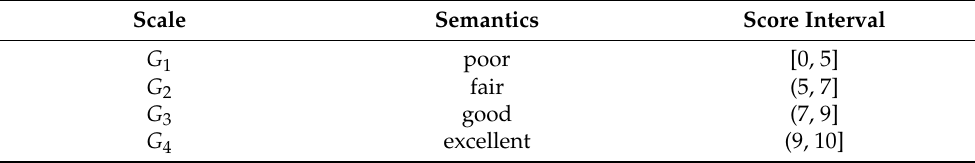
Table 2. The scales for performance